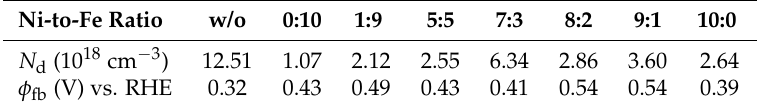
Figure 6. Mott–Schottky curves for Ni x Fe 1 − x O y /hematite photoanodes with various Ni-to-Fe ratios of the precursor measured at the light-off condition. The immersion time for depositing Ni x Fe 1 − x O y was 2 min. The curve for the bare hematite photoanode is also shown for comparison. Table 1. Information retrieved from the Mott–Schottky analysis based on the low-potential region: N d : doping density (electron density); φ fb : flat-band potential. RHE: reversible hydrogen electrode. Ni-to-Fe Ratio w/o 0:10 1:9 5:5 7:3